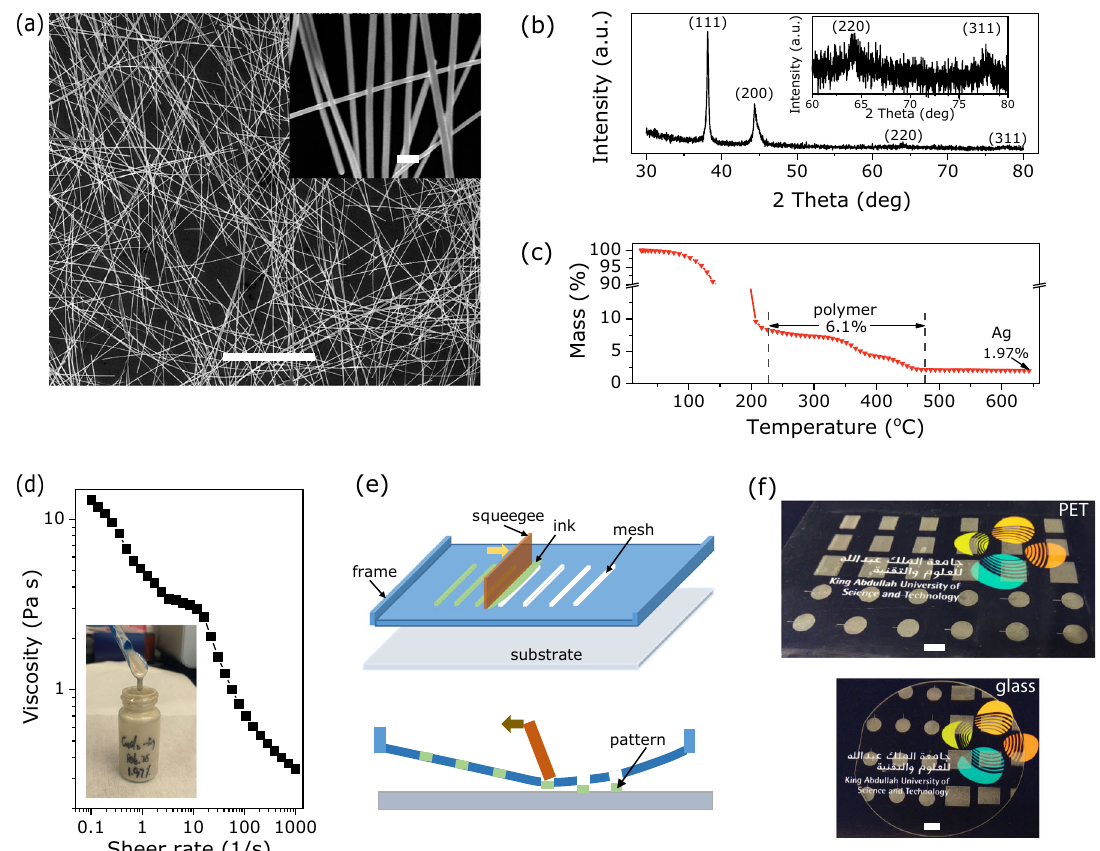
Fig. 2 Properties of the synthesized Ag NWs and the prepared Ag NW ink. a SEM images of synthesized Ag NWs. The scar bar is 10 µm. The inset is a magni fi ed image to highlight the diameter. The scale bar in the inset is 200 nm. b XRD pattern of synthesized Ag NWs. c The thermogravimetric analysis (TGA) of prepared Ag NW screen-printing ink; 6.1% represents the content of the ethylene cellulose (EC) and PVP in ink and 1.97% denotes the residue mass, indicating the Ag loading. d Viscosity at shear rates ranging from 0.1 to 1000 s − 1 for the Ag NW ink. The inset is a photograph of the prepared Ag NW ink. e Schematic of the screen-printing process. f The digital images of the screen- printed Ag NW patterns on a fl exible poly(ethylene terephthalate) fi lm (top panel) and a rigid glass (bottom panel) with the KAUST logos as the background. The scale bars are 10